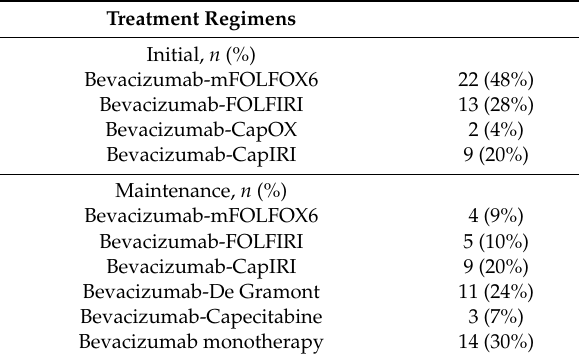
Table 2. Initial and maintenance therapeutic regimens.